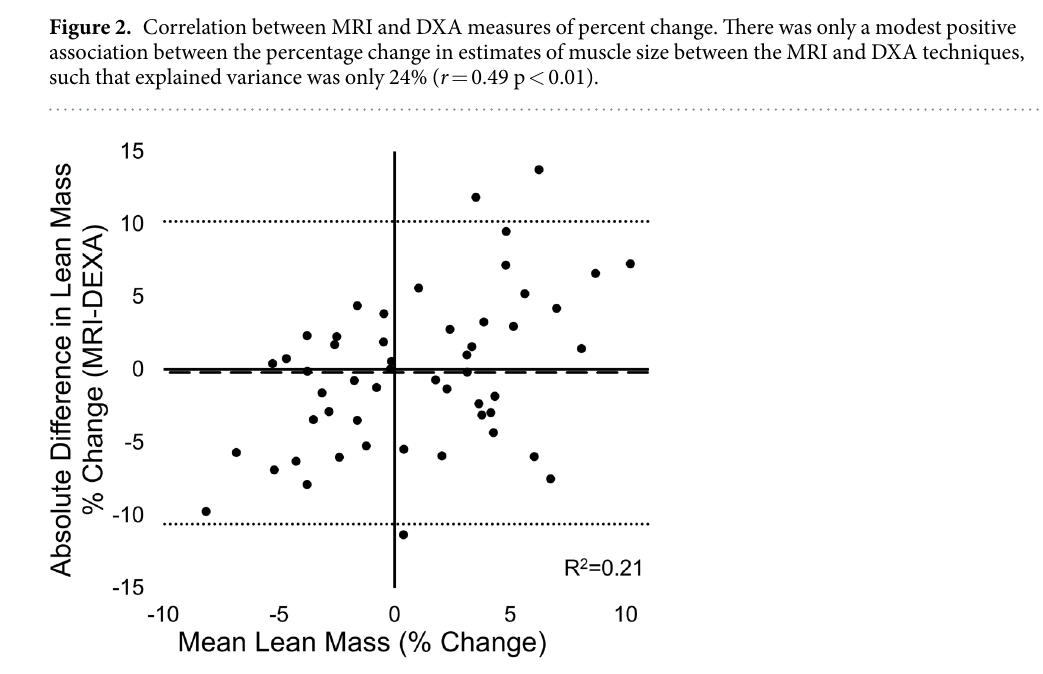
Figure 3. Bland-Altman plot of agreement between MRI- and DXA-derived measures of percent change in muscle size. There was a relationship between the error (difference between MRI and DXA) and the mean percent change in skeletal muscle size, indicating heteroscedacity. Upper LOA was 10.19% and lower LOA was − 10.61% (dotted lines). DXA demonstrated a bias of − 0.21% (dashed